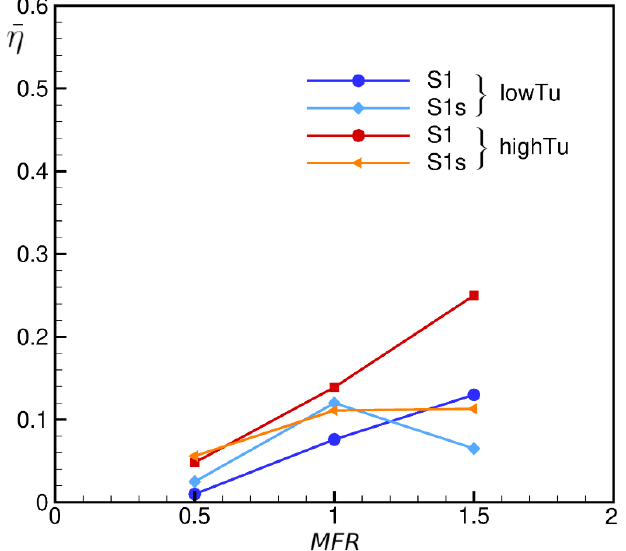
Figure 13. Platform rotor blade film cooling effectiveness (measured at x/C ax = 20%) as a function of the mass flow ratio with density ratio DR = 1.5—turbulence effect— Tu % = 0.72 & 13 (figure newly created herein using data taken from [18]).